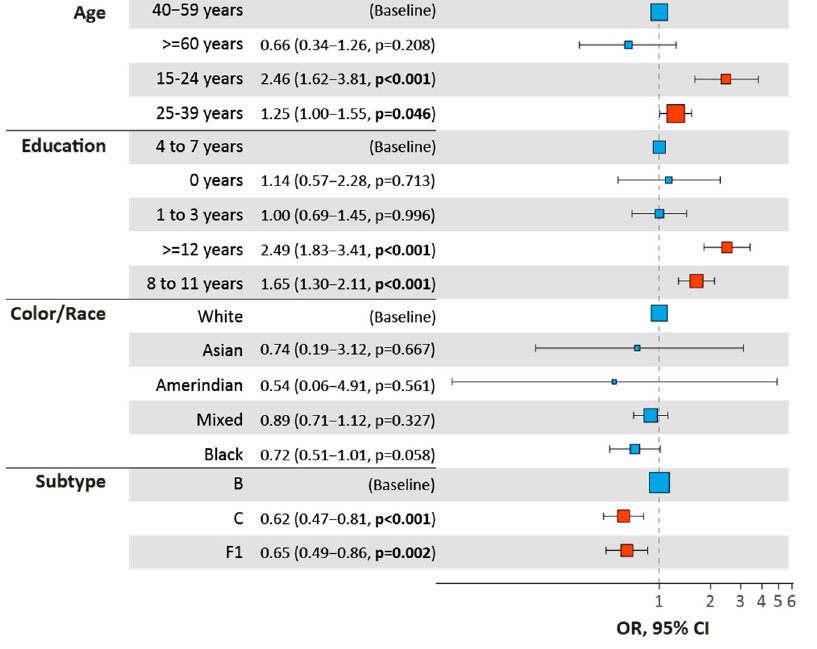
Figure 5. Odds ratio of males clustering with men, compared to males clustering with women in clusters identified with 4.5%